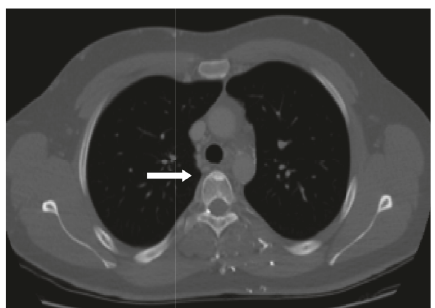
Figure 4: (Chest contrast enhanced CT) : Axial bone window CT demonstrating a solitary osteoblastic lesion at T5 (white